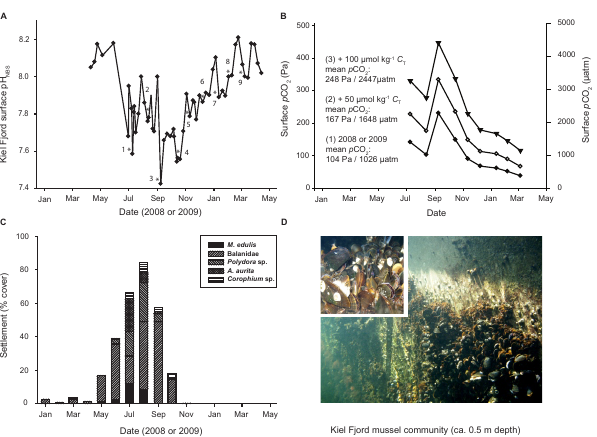
Kiel Fjord mussel community (ca. 0.5 m depth)